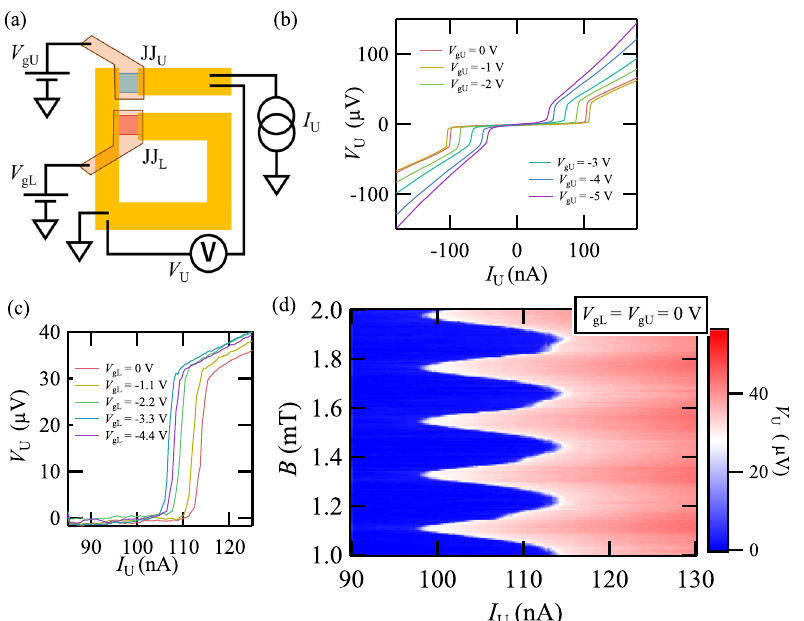
Fig. 3 Switching current oscillation indicating a coherent coupling between two Josephson junctions. a Shows a schematic of the measurement circuit for sample B . b Illustrates the I U − V U curves obtained at several V gU points, indicating that the supercurrent in JJU can be tuned by V gU locally. c Indicates V I B = 1.9 mT and several V U vs. U at gL . The supercurrent in JJU is little controllable by red and blue regions corresponds to the switching current in JJU as a function of B . The image clearly indicates the oscillation of the switching current in the